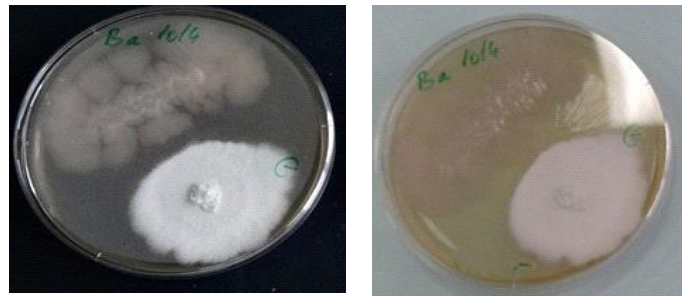
Figure 3. Images of experimental study regarding the antagonism between Bacillus. amyloliquefa- ciens 1014 and Ganoderma lucidum.